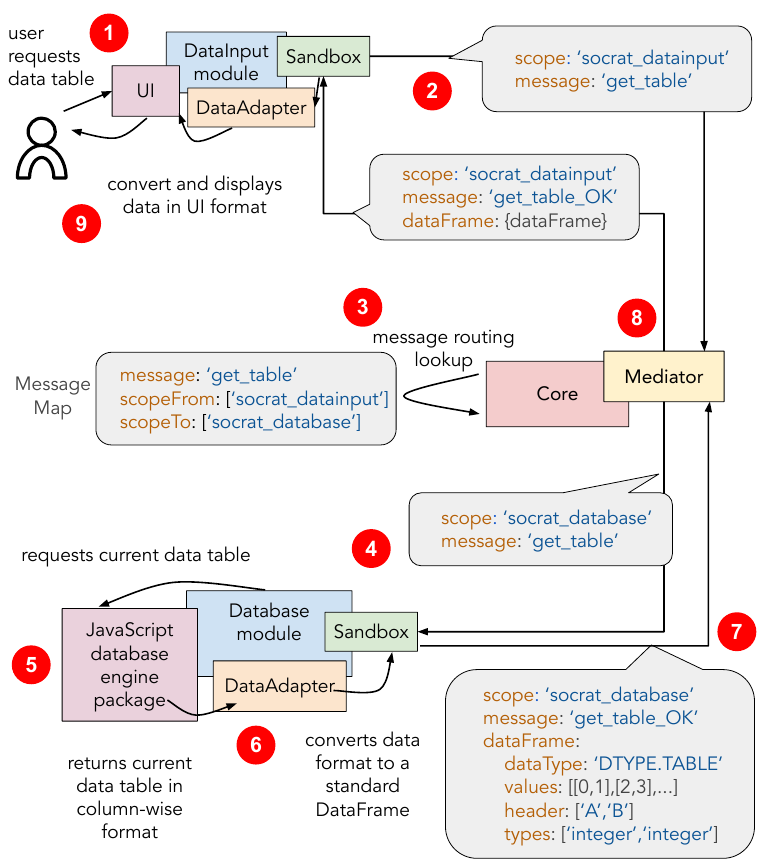
Figure 2. An exemplar scenario demonstrating SOCRAT module interaction mechanism: ( 1 )